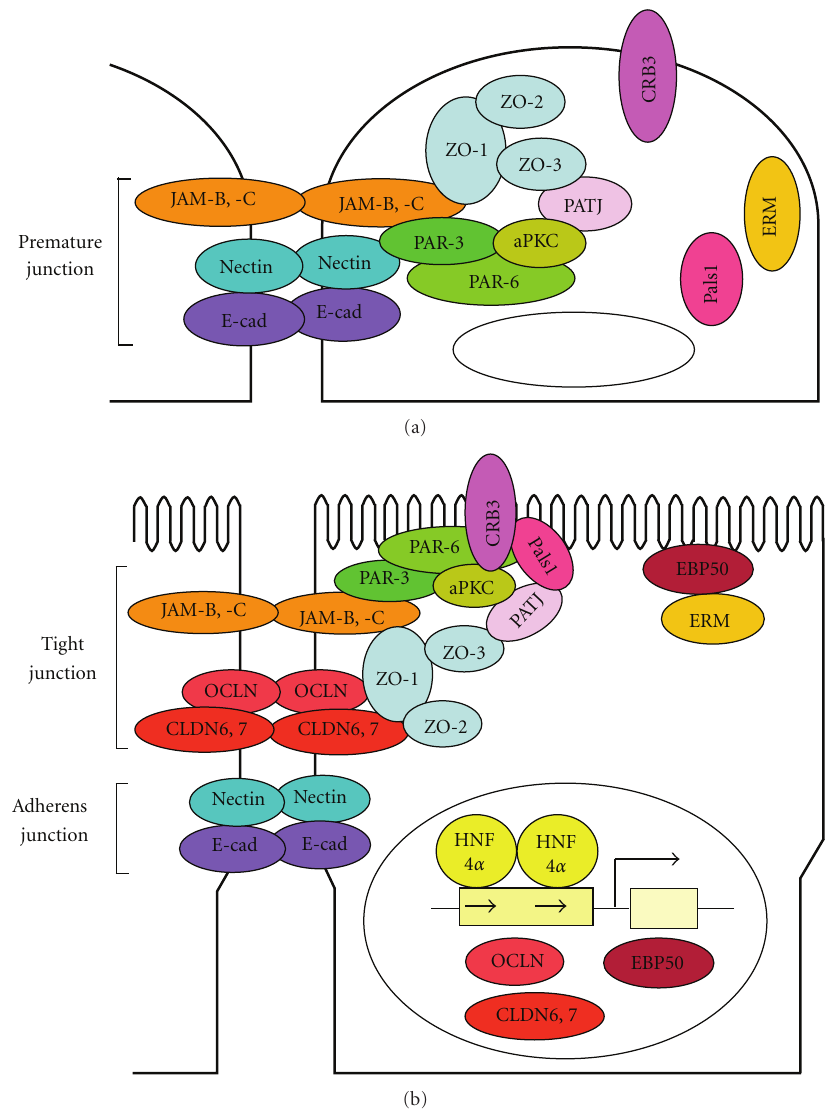
Figure 2: Models of HNF4 α -triggered formation of tight junctions and microvilli in F9 cells. (a) In an undi ff erentiated state, several junctional proteins are accumulated to premature junctions. (b) HNF4 α provokes the formation of junctional complexes and microvilli via induction of expression of occludin [OCLN], claudin-6 [CLDN6], claudin-7 [CLDN7], and ezrin/radixin/moesin-binding phosphoprotein 50